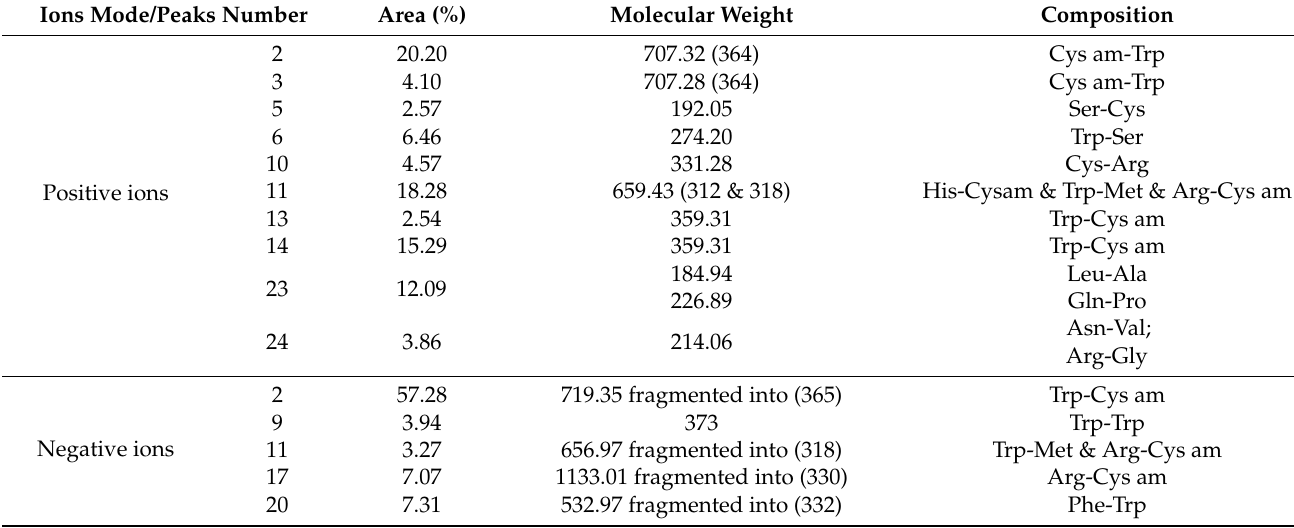
Table 1. Possible peptide compositions of AMPs within size exclusion chromatography fraction 1 (SEC-F1) estimated by electro-spray- ionization MS (ESI-MS)